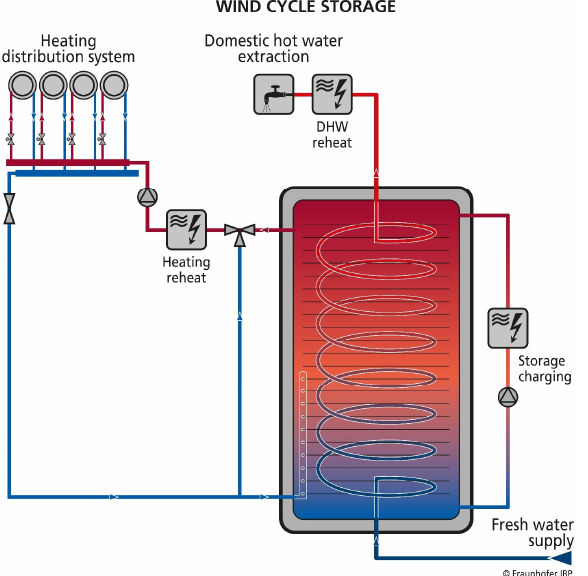
Figure 1. Sketch diagram of the hydraulic concept of the water-based heat storage system with the hot water tank.